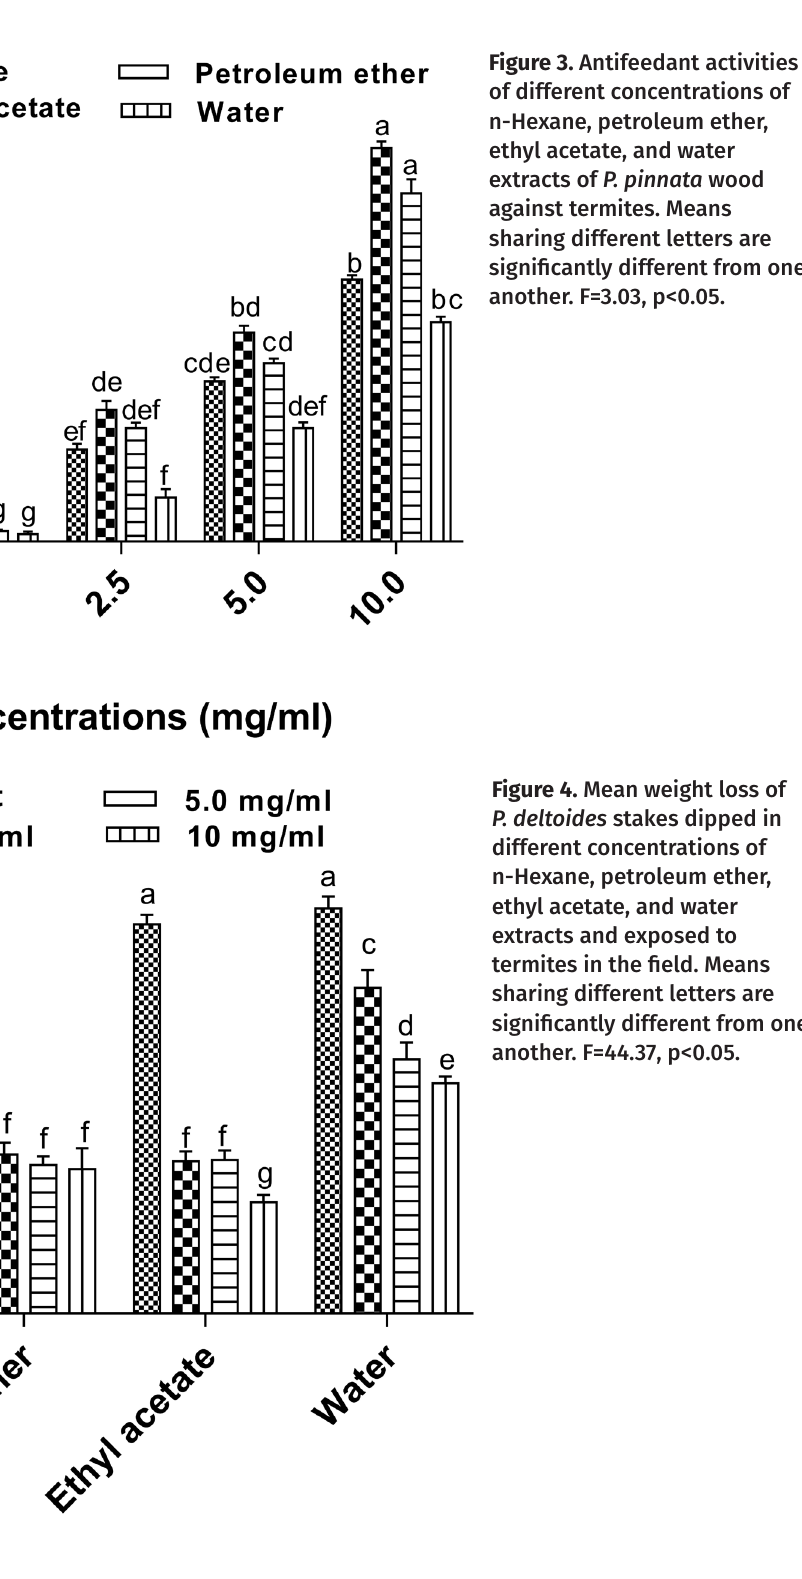
Figure 4. Mean weight loss of P. deltoides stakes dipped in different concentrations of n-Hexane, petroleum ether, ethyl acetate, and water extracts and exposed to termites in the field. Means sharing different letters are significantly different from one another. F=44.37, p<0.05.